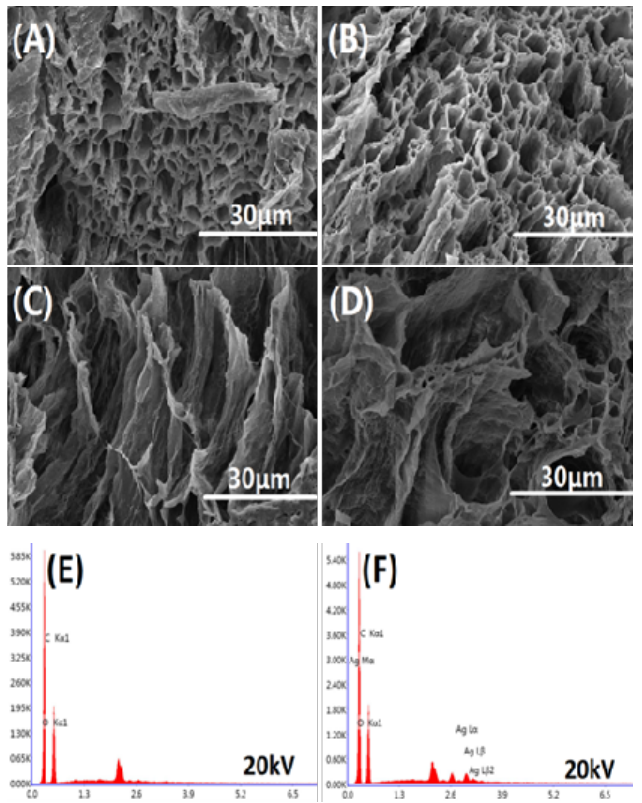
Figure 5. FT-IR (Fourier transform infrared spectroscopy) of AgCl/PVA/PEG/CS hydrogels loaded with ( A ) 0 mM, ( B ) 2.5 mM, ( C ) 5 mM, and ( D ) 7.5 mM AgCl NPs.